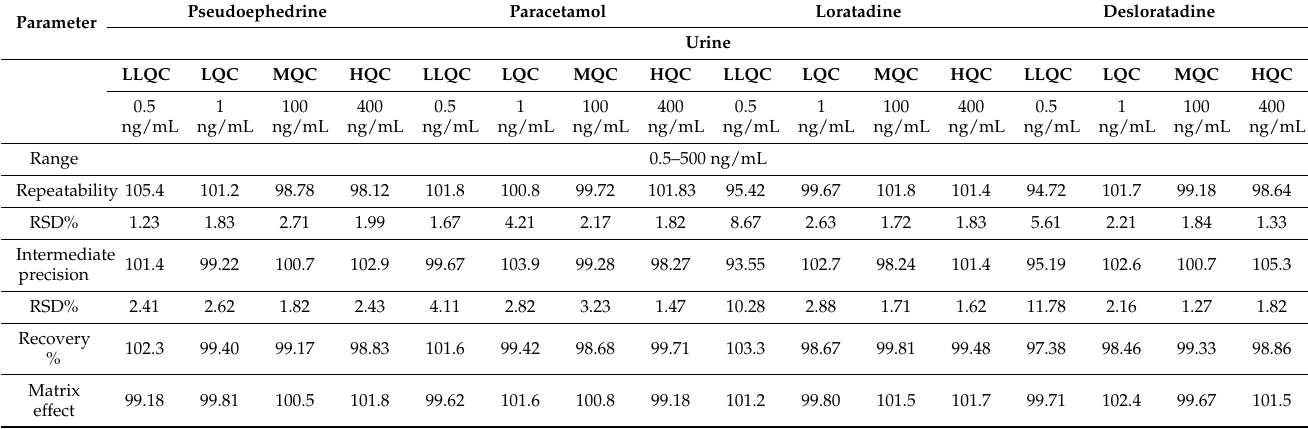
Table 5. Validation parameters of the SPE-HPC-MS method in urine samples.